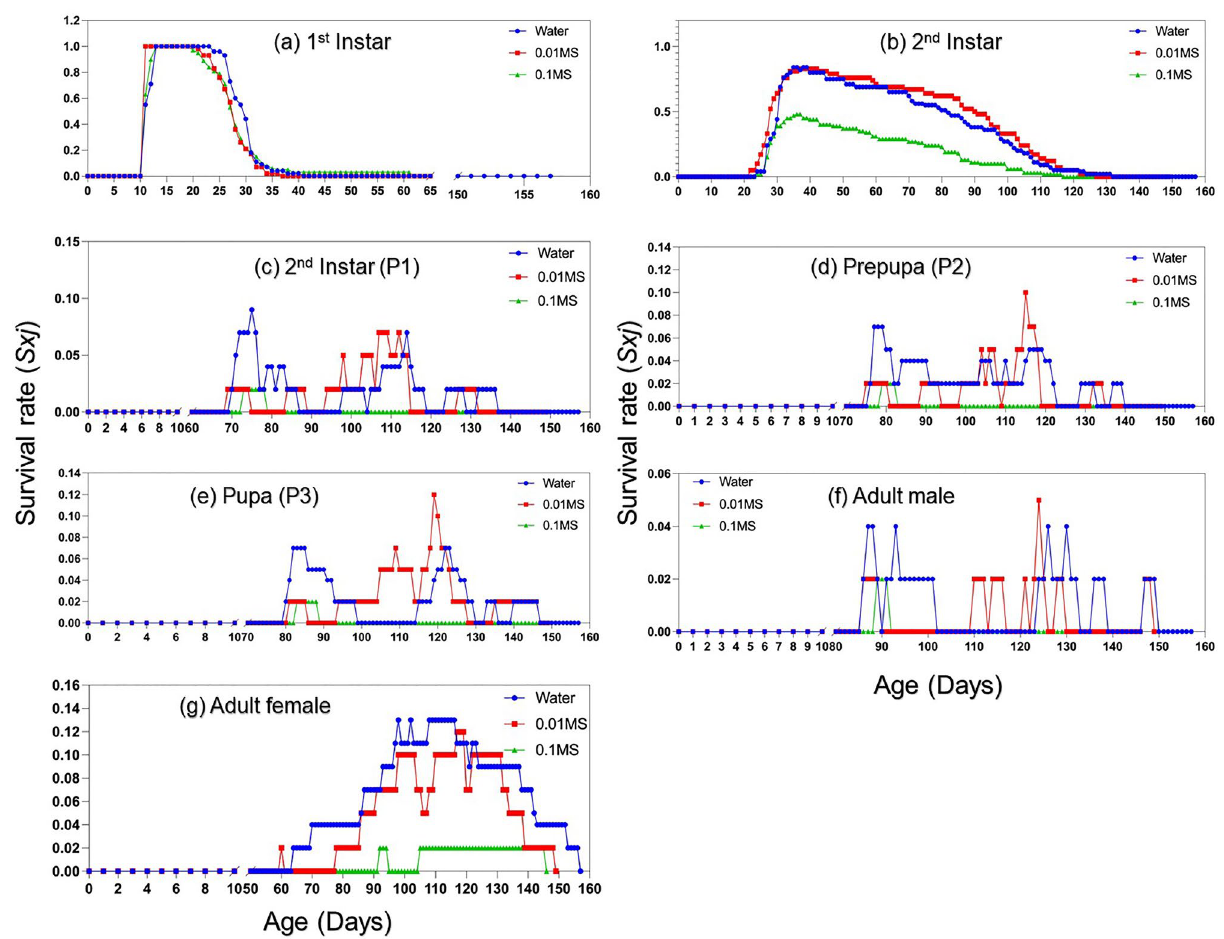
Figure 2. Age-stage specific survival rate ( s xj ) of A. lagerstroemiae at different nutrient conditions (Water, 0.01MS, and 0.1MS), grouped by different stages: ( a ) 1st instar, ( b ) 2nd instar, ( c ) 2nd instar (P1), ( d ) prepupa (P2), ( e ) pupa (P3), ( f ) adult male, and ( g ) adult